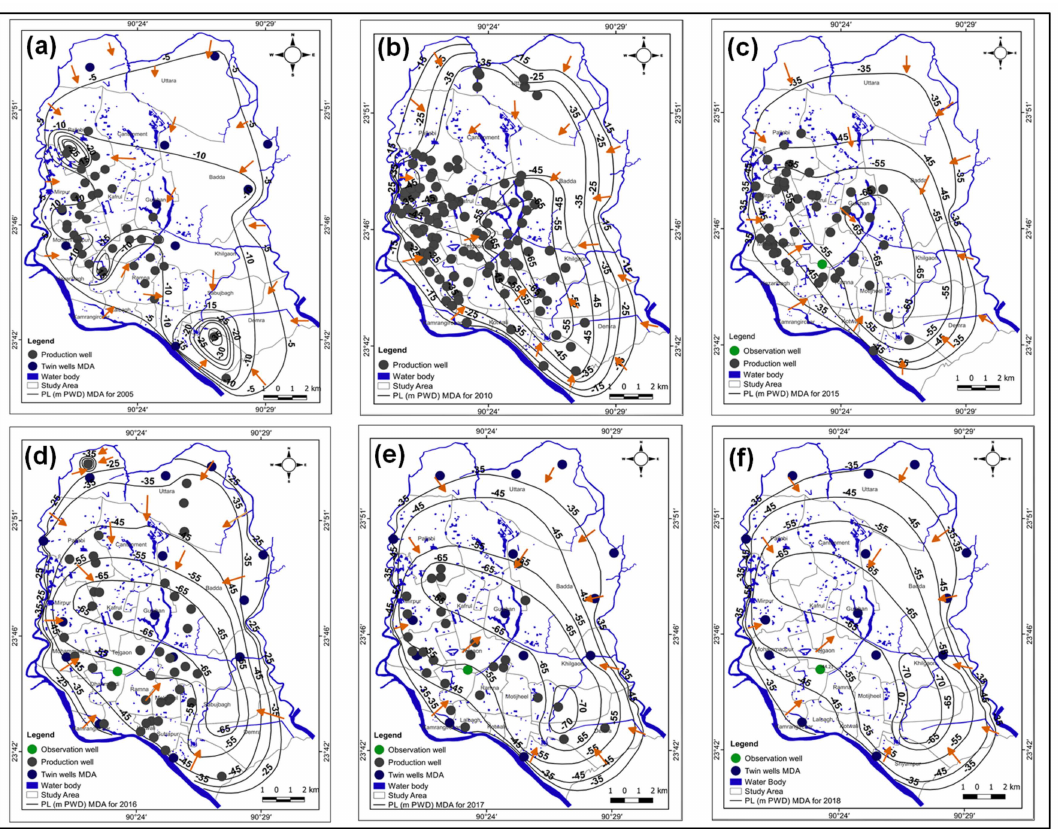
Figure 12. Piezometric maps of Middle Dupi Tila aquifer (MDA) in Dhaka city. ( a ) 2005, ( b ) 2010, ( c ) 2015, ( d ) 2016, ( e ) 2017, ( f )